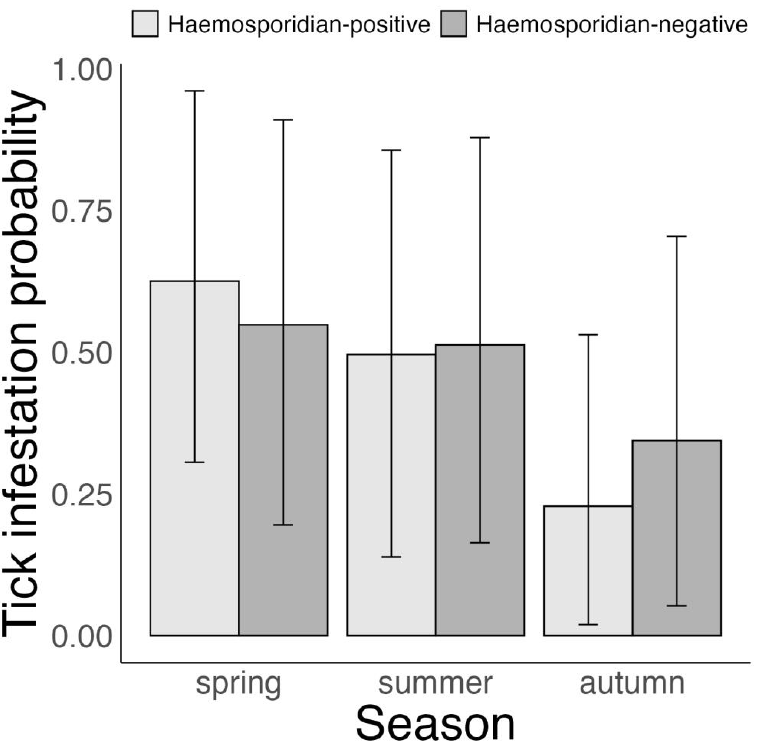
Figure 1. Bayesian Bernoulli distribution model on variation in Ixodes ricinus infestation probability according to haemosporidian infection status of 6 avian host species in Slovakia, 2017–2019. Displayed are posterior means and 95% CrI.